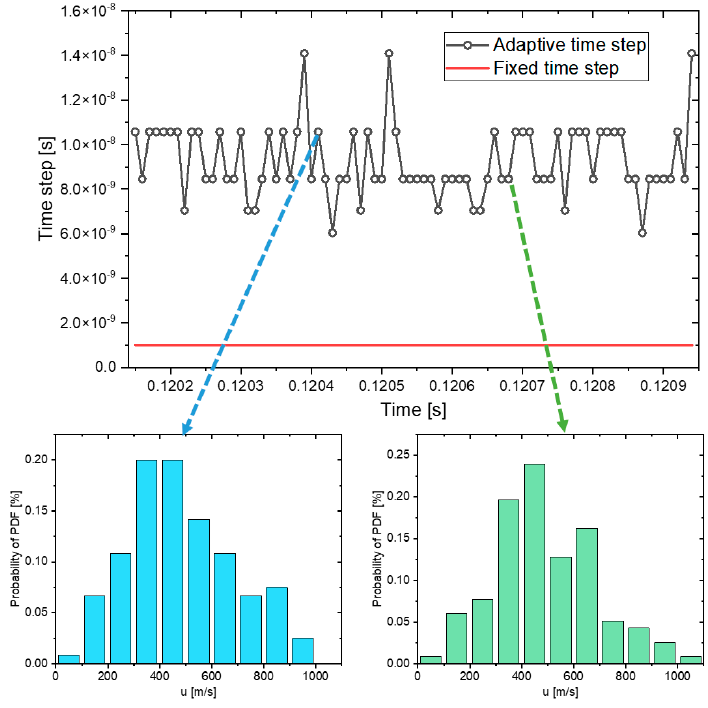
Figure 4. Verification of time step.